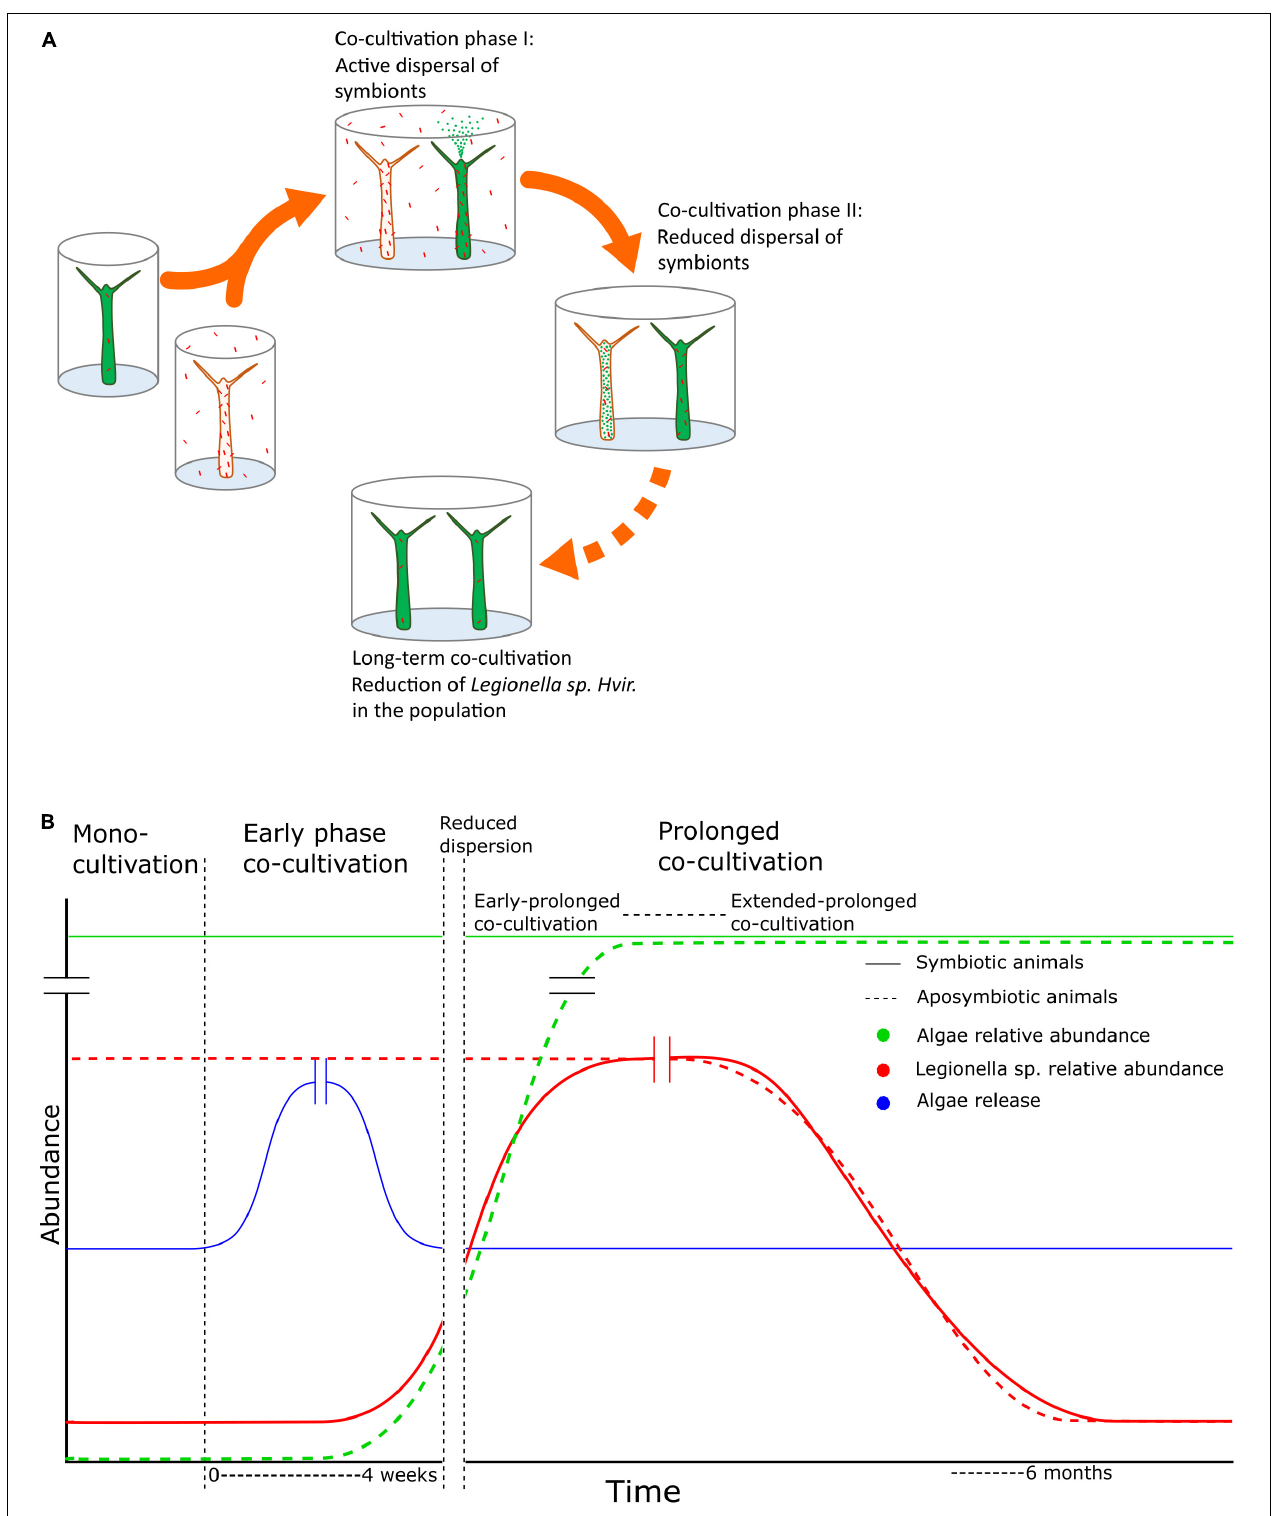
FIGURE 4 | Summary figure. Summarized graphically in panels (A,B) , we represent the temporal dynamics of Legionella spp. Hvir in the population of aposymbiotic and symbiotic animals over a prolonged co-cultivation. There is a phase of active dispersal of symbionts during early co-cultivation followed by reduced dispersal. During this phase, the microbiome of both the strains changes over the course of time till the system reaches the phase of equilibrium in respect of alteration of microbiome composition and the entire population has a uniform microbial composition.